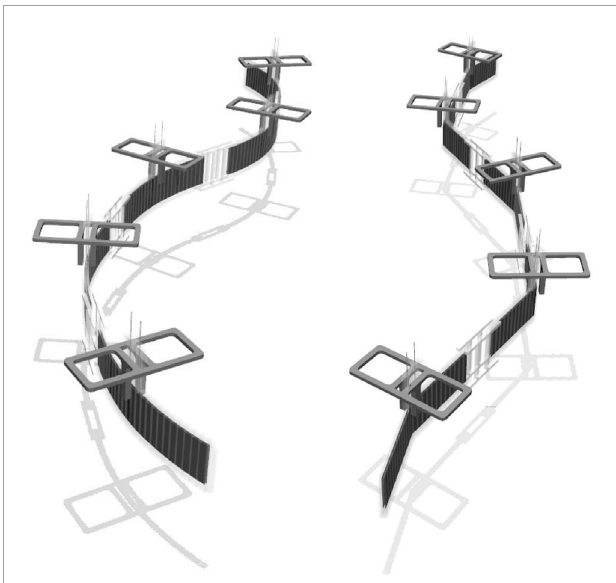
FIGURE 1 Morphological structures of a soft snake robot (left) and a rigid snake robot (right) in the simulation